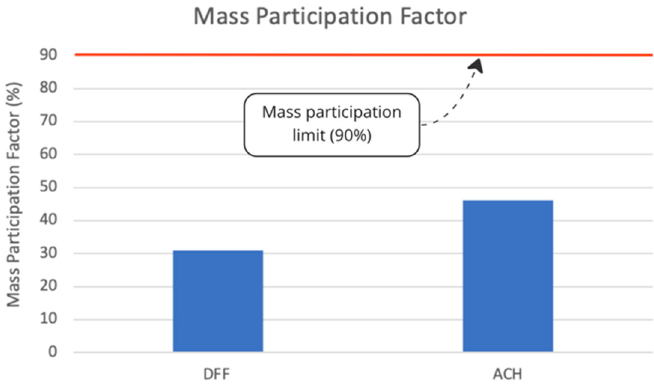
Figure 26. Mass participation factor of DFF and ACH against the suggested limit.